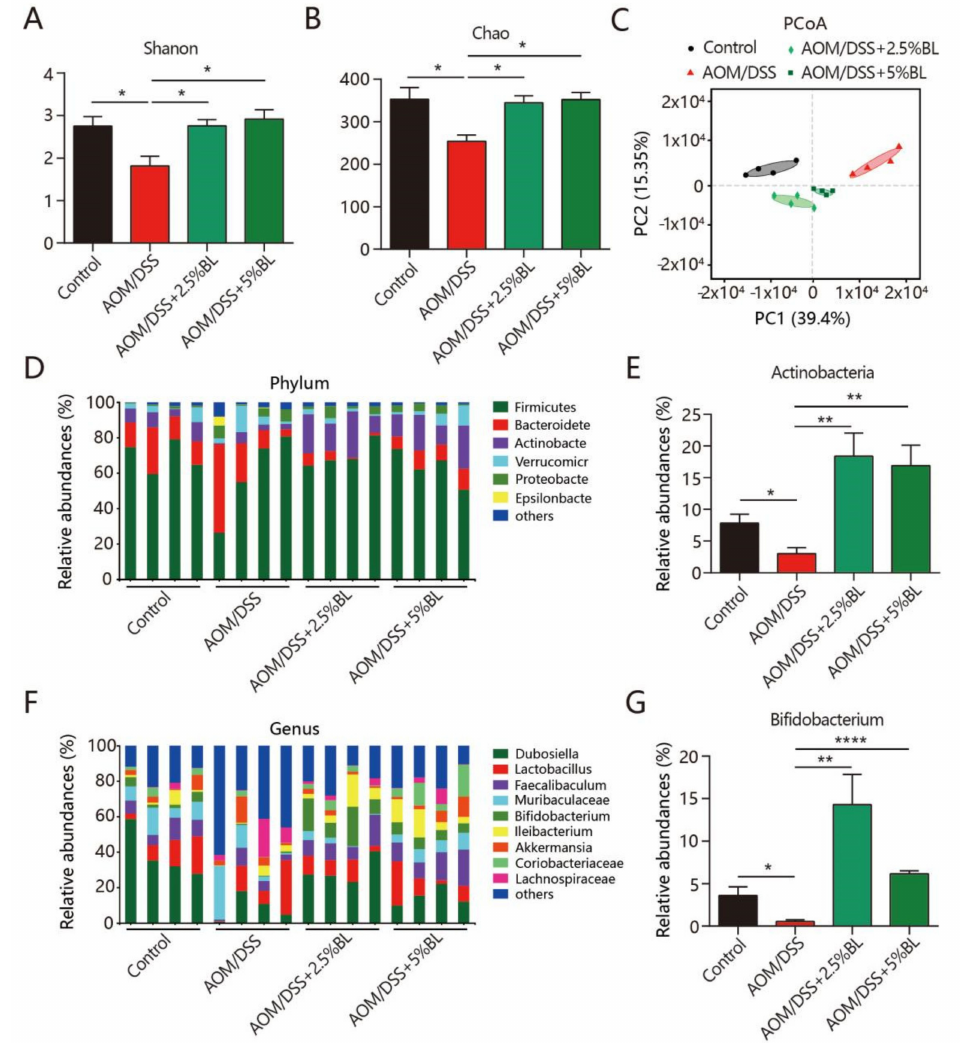
Figure 6. BL improves AOM/DSS-induced gut microbiota dysbiosis. ( A ) Shannon index and ( B ) Chao index. ( C ) PCoA of the fecal bacterial composition. ( D ) Distributions of bacterial community at phylum level and ( E ) the relative abundance of Actinobacteria. ( F ) Distributions of bacterial community at genus level and ( G ) the relative abundance of Bifidobacterium. * p < 0.05, ** p < 0.01, and **** p < 0.0001. The results are expressed as mean ± SEM. BL, barley leaf; AOM, azoxymethane; DSS, dextran sodium